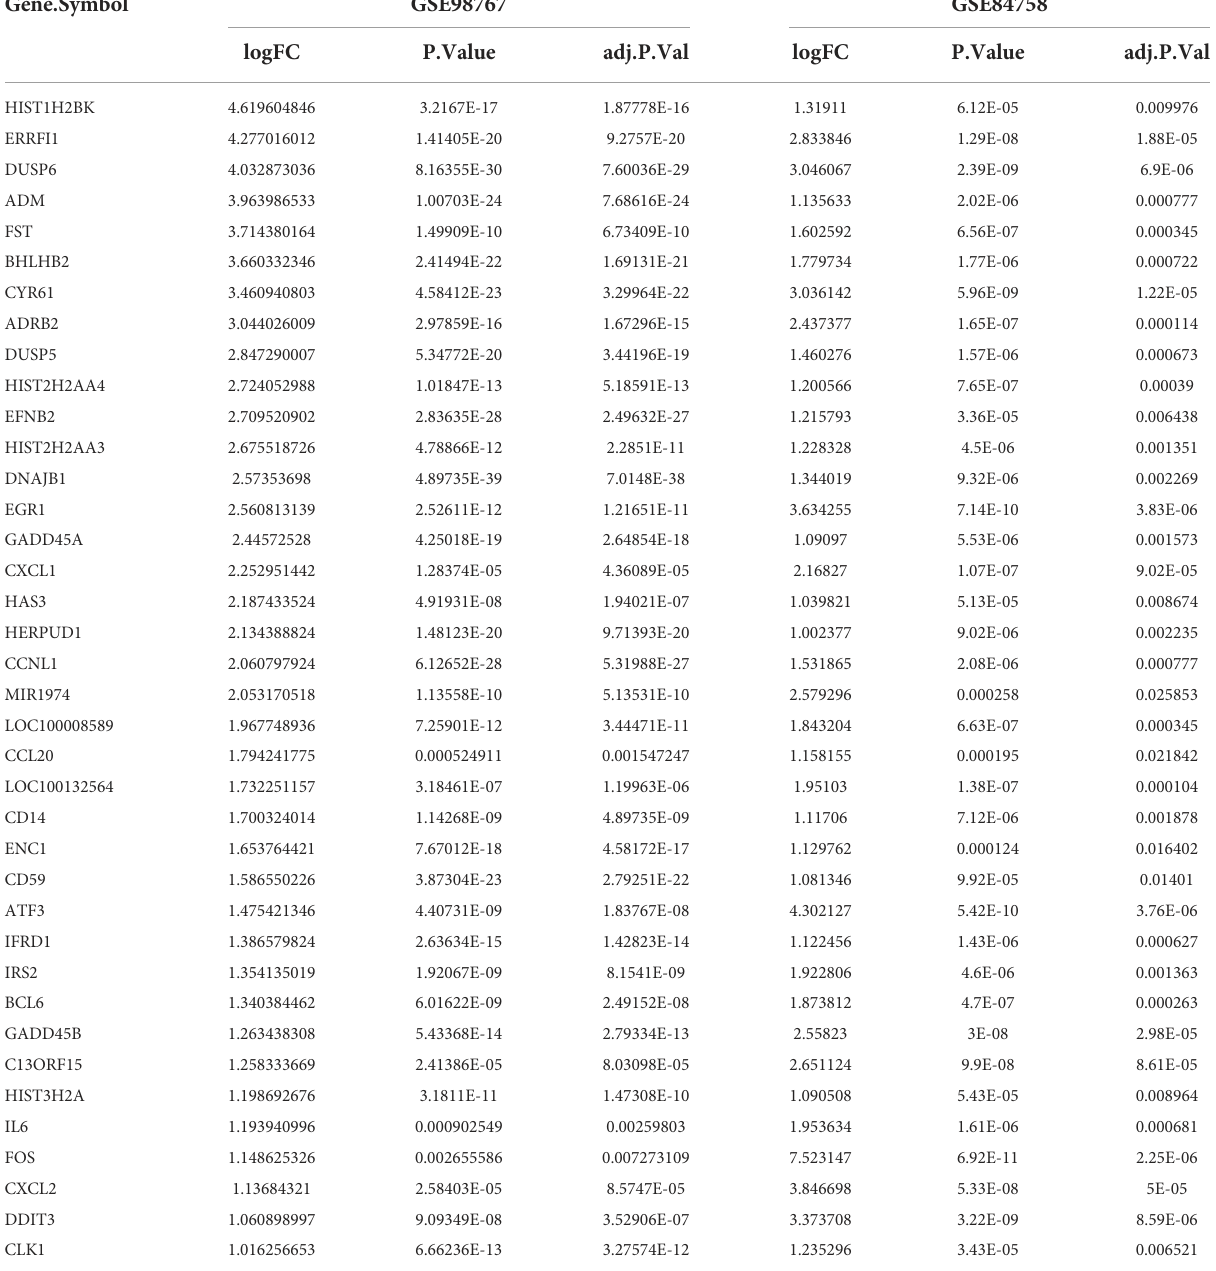
TABLE 1 Detailed data of 38 differential expressed cSCC-PDT-related genes.